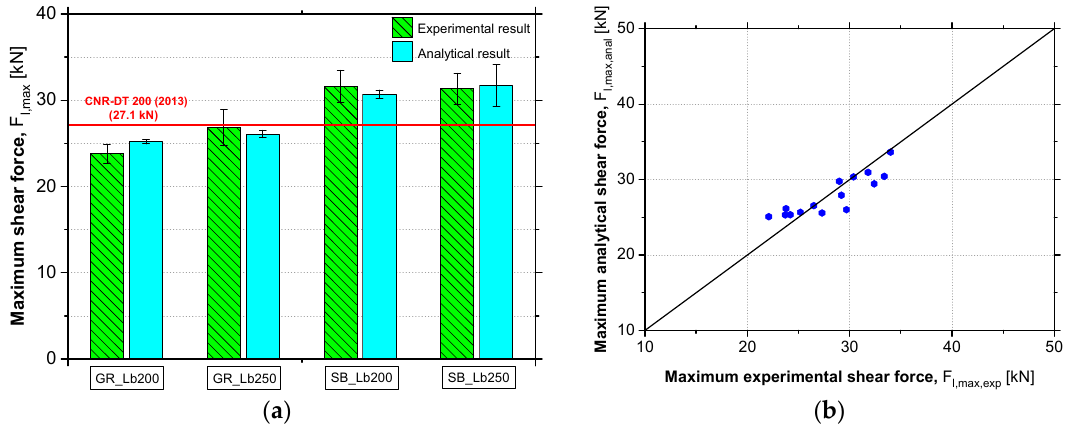
Figure 12. Comparison between the experimental results, the analytical results and the prediction provided by National Research Council [1] ( a ) and the accuracy of the proposed analytical model ( b ).